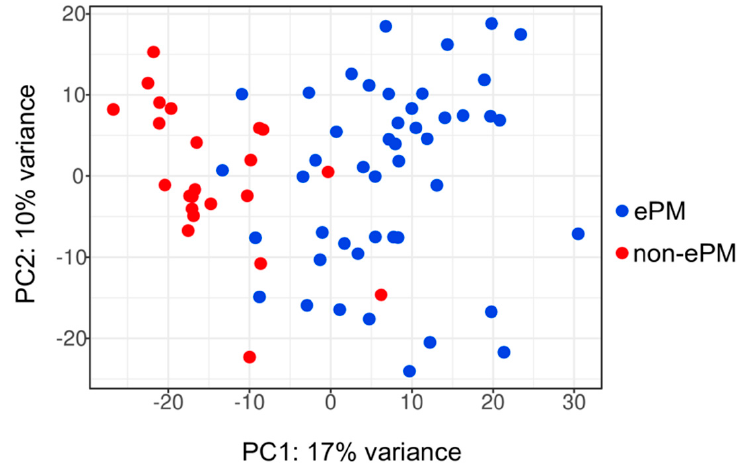
Figure 1. Principal component analysis (PCA) of the RNA-Seq cohort of samples. In blue ePM, epithelioid pleural mesothelioma; in red non-ePM, non-epithelioid pleural mesothelioma. The x -axis indicates principal component 1; the y -axis indicates principal component 2.